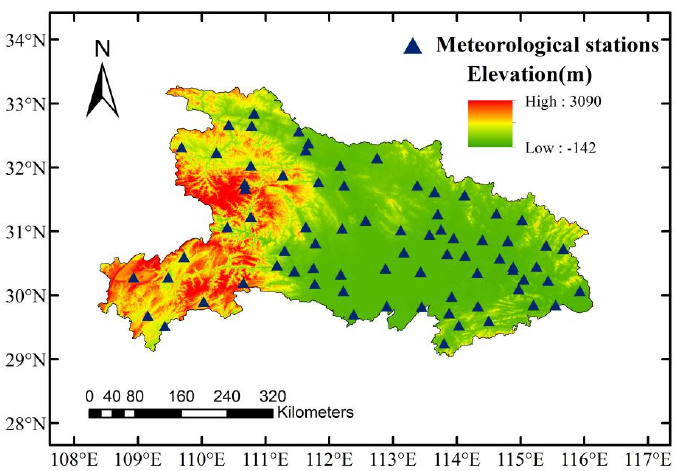
Figure 2. The spatial distribution of meteorological sites and digital elevation model (DEM) data representation.